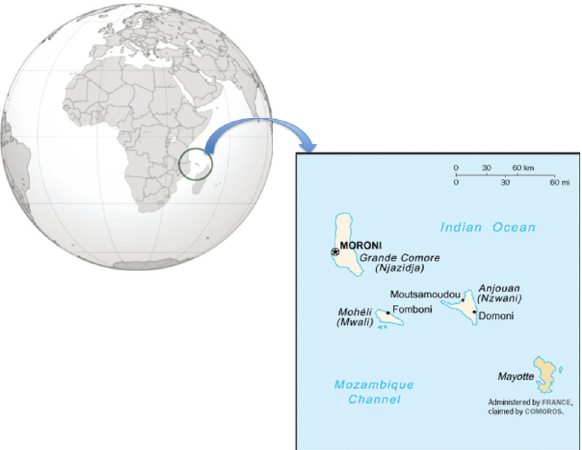
Figure 1 - Location of the Comorian Archipelago between east Africa and Madagascar in the Indian Ocean . Four islands compose the Comorian ar- chipelago. Three belong to the Federal Islamic Republic of the Comoros and the fourth one, Mayotte, is French (Modified from https://up-